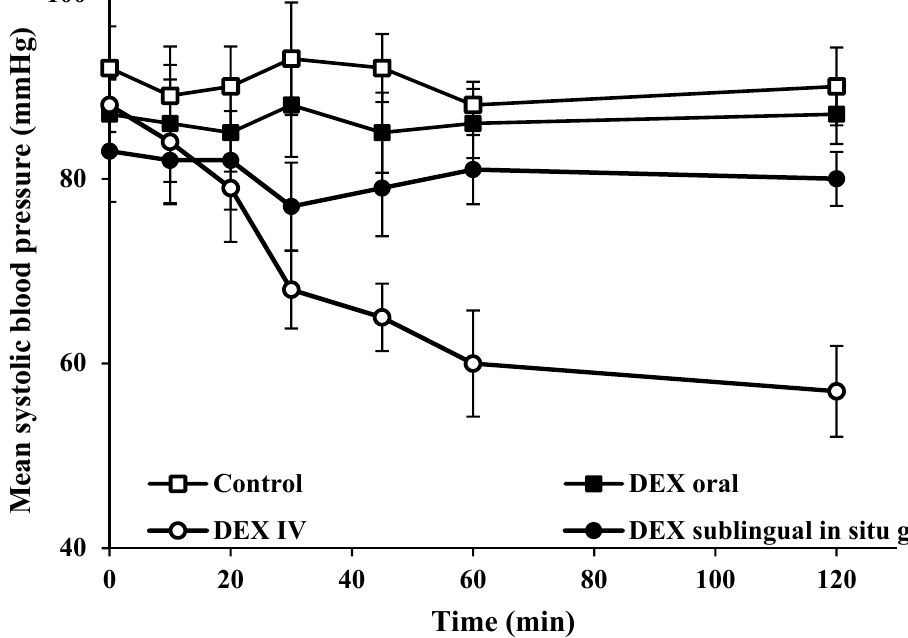
Figure 5. Effect of sublingual administration of DEX in situ gel (F3), oral and IV administration of DEX on the systolic blood pressure of rats.